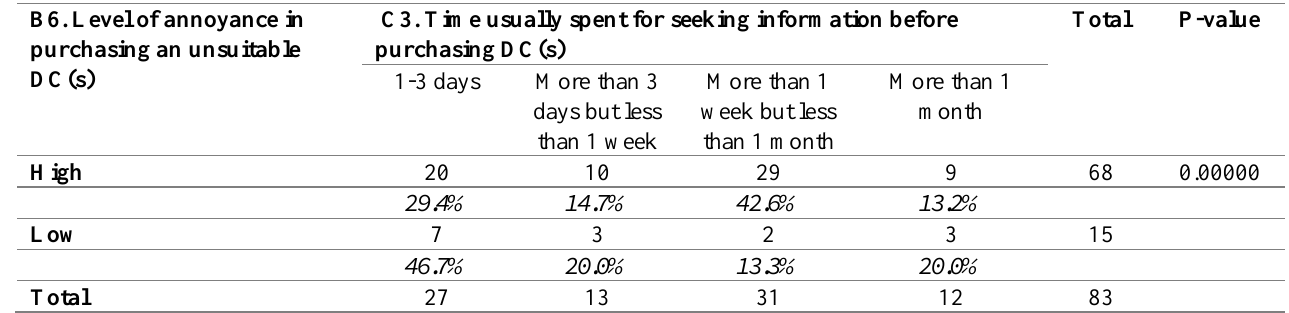
Table 9. Result For Hypothesis Table 6. Result For Hypothesis 5